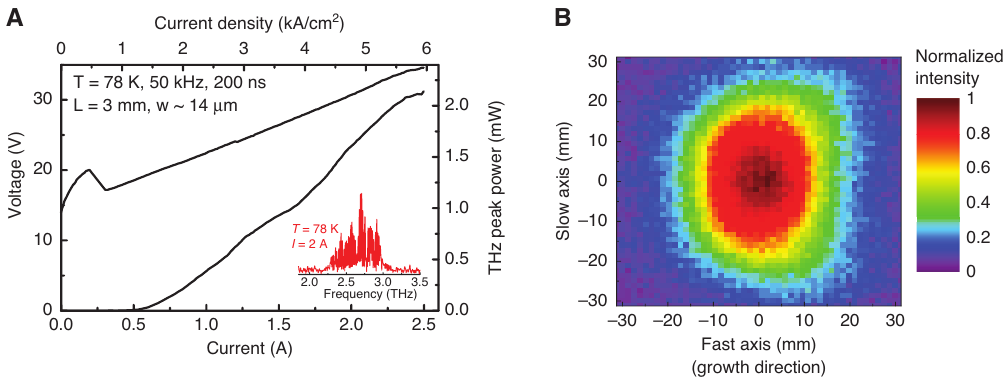
Figure 20: Performance of THz DFG-QCL operated at 78 K for terahertz imaging. (A) Current-light output characteristics of the THz emission of a 3-mm-long, 14- μ m-wide DFB/FP device measured at 78 K, and voltage (left axis) versus current density. (B) The 2D far-field intensity profile of the device shown in (A).